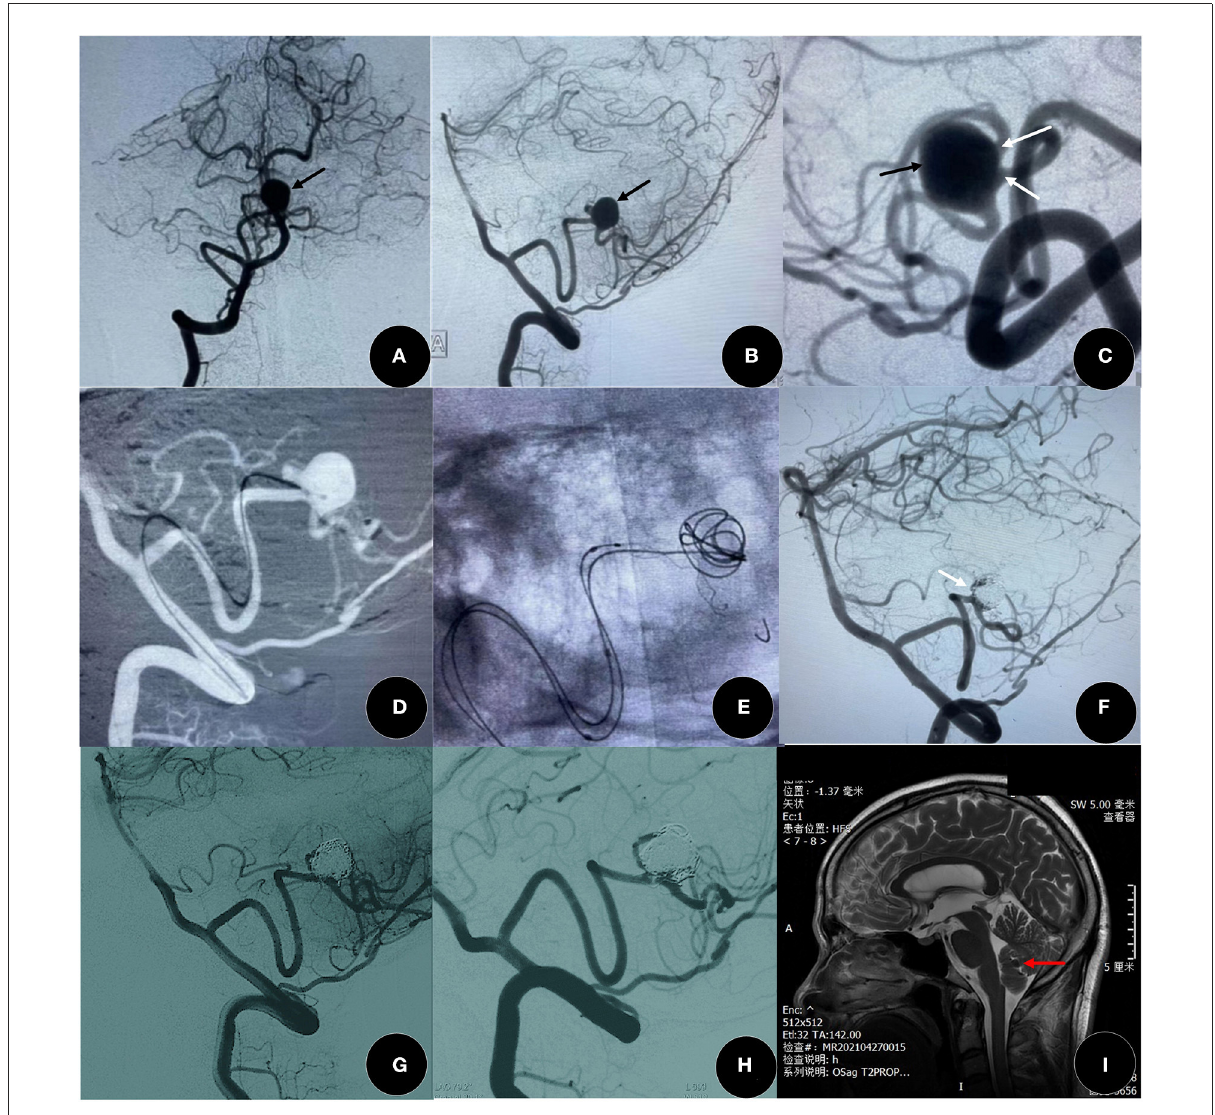
FIGURE3 A 51-year-old woman presented with a headache for 1 year. (A–C) The angiographic result showed a distal posterior inferior cerebellar artery (PICA) aneurysm (black arrow) with two side branches (white arrow). (D–G) The aneurysm was in good occlusion (RROC 2) by Leo plus baby (2.5mm × 18mm) assisted coiling, and two branches were well-protected (white arrow). (G,H) The degree of occlusion increased to complete occlusion (RROC 2) at 9 months after surgery. (I) There is no new cerebral infarction after the confirmation of SAC by MRI, and red arrow indicates coils. SAC, stent-assisted